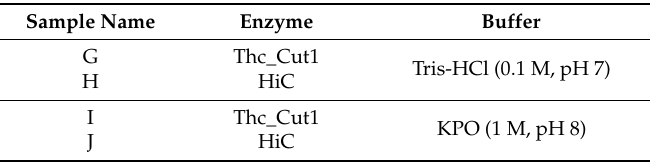
Table 2. Overview PEF film hydrolysis